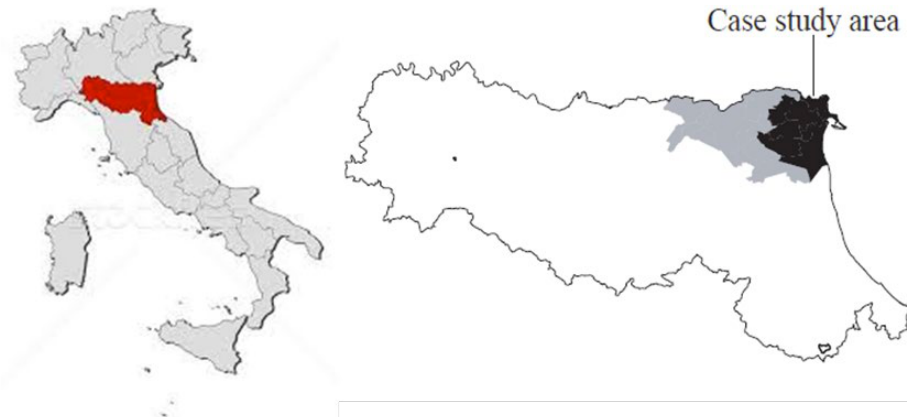
Figure 1. Location of the case study area: Po River Delta, Ferrara Province,